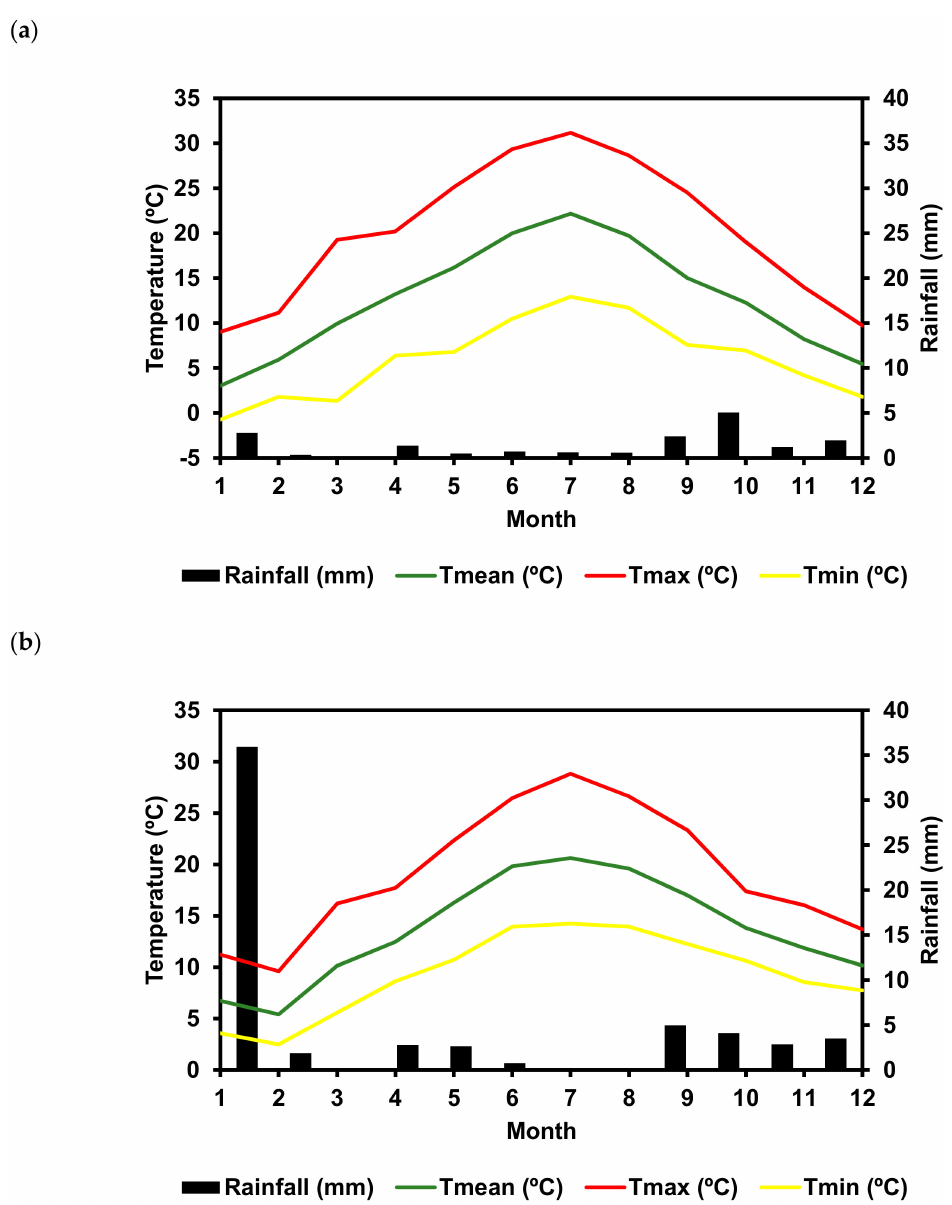
Figure 6. Distribution of rainfall and maximum (Tmax), minimum (Tmin), and mean temperatures (Tmean) in the ( a ) Bierzo D.O. and ( b ) D ã o D.O. in 2015. 2.3. Impact of the Phenolic Composition on the Color of Red Wines from ‘Menc í a’ / ‘Jaen’ As expected from the phenolic composition of ‘Menc í a’ / ‘Jaen’ wines, ‘Jaen’ wines from D ã o D.O. presented a significantly higher color intensity when compared to ‘Menc í a’ wines from Bierzo D.O. (14.1 vs. 11.3 a.u., p < 0.00687, respectively, Table 4). The color intensity for ‘Menc í a’ wines from Bierzo D.O. obtained in this work was in accordance with the values described by Revilla et al. [52] for young red wines produced with ‘Menc í a’ grapes in AOC Valdeorras (Galicia) (range from 6.43 to 17.21 a.u.), by Garc í a-Falc ó n et al. [27] also for ‘Menc í a’ wines (range from 11.2 to 12.6 a.u.), by Bouzas-Cid et al. [16] (range from 9.1 to 10.8 a.u.), and by Soto V á zquez et al. [29] (range from 7.37 to 11.57 a.u.). However, Blanco et al. [21] obtained lower color intensity values for ‘Menc í a’ monovarietal wines produced in Galicia (range from 6.87 to 7.67